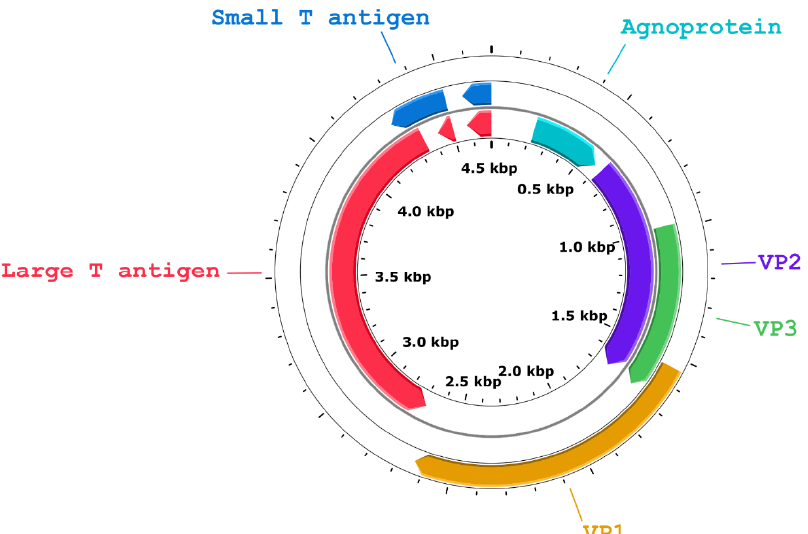
Figure 4. Genome organization of BoPyV-1/Faber/2021/Uy (GenBank accession number OM938033). The different proteins are represented with arrows according to their location in the genome; arrow direction indicates the strand. The agnoprotein (position 220–250), VP1 (position 1540–2637), VP2 (position 618–1679), and VP3 (position 981–1679) are located on one strand and the LT antigen (joined